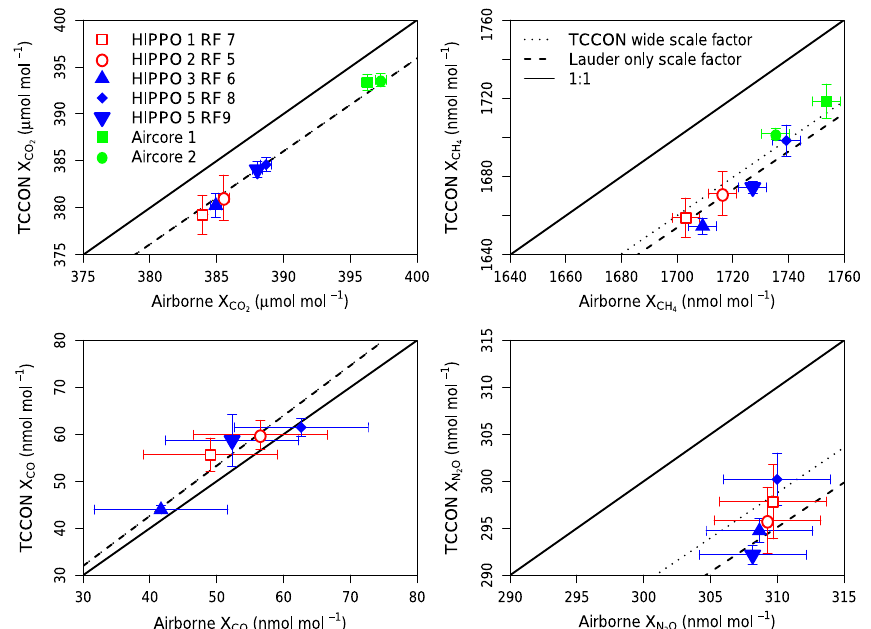
, X CH , X CO and X N with fitted linear relationships derived for the TCCON network 2 4 2 O